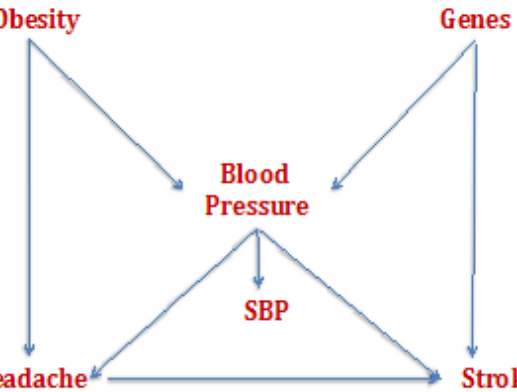
Figure 3. DAG for the association between headache and